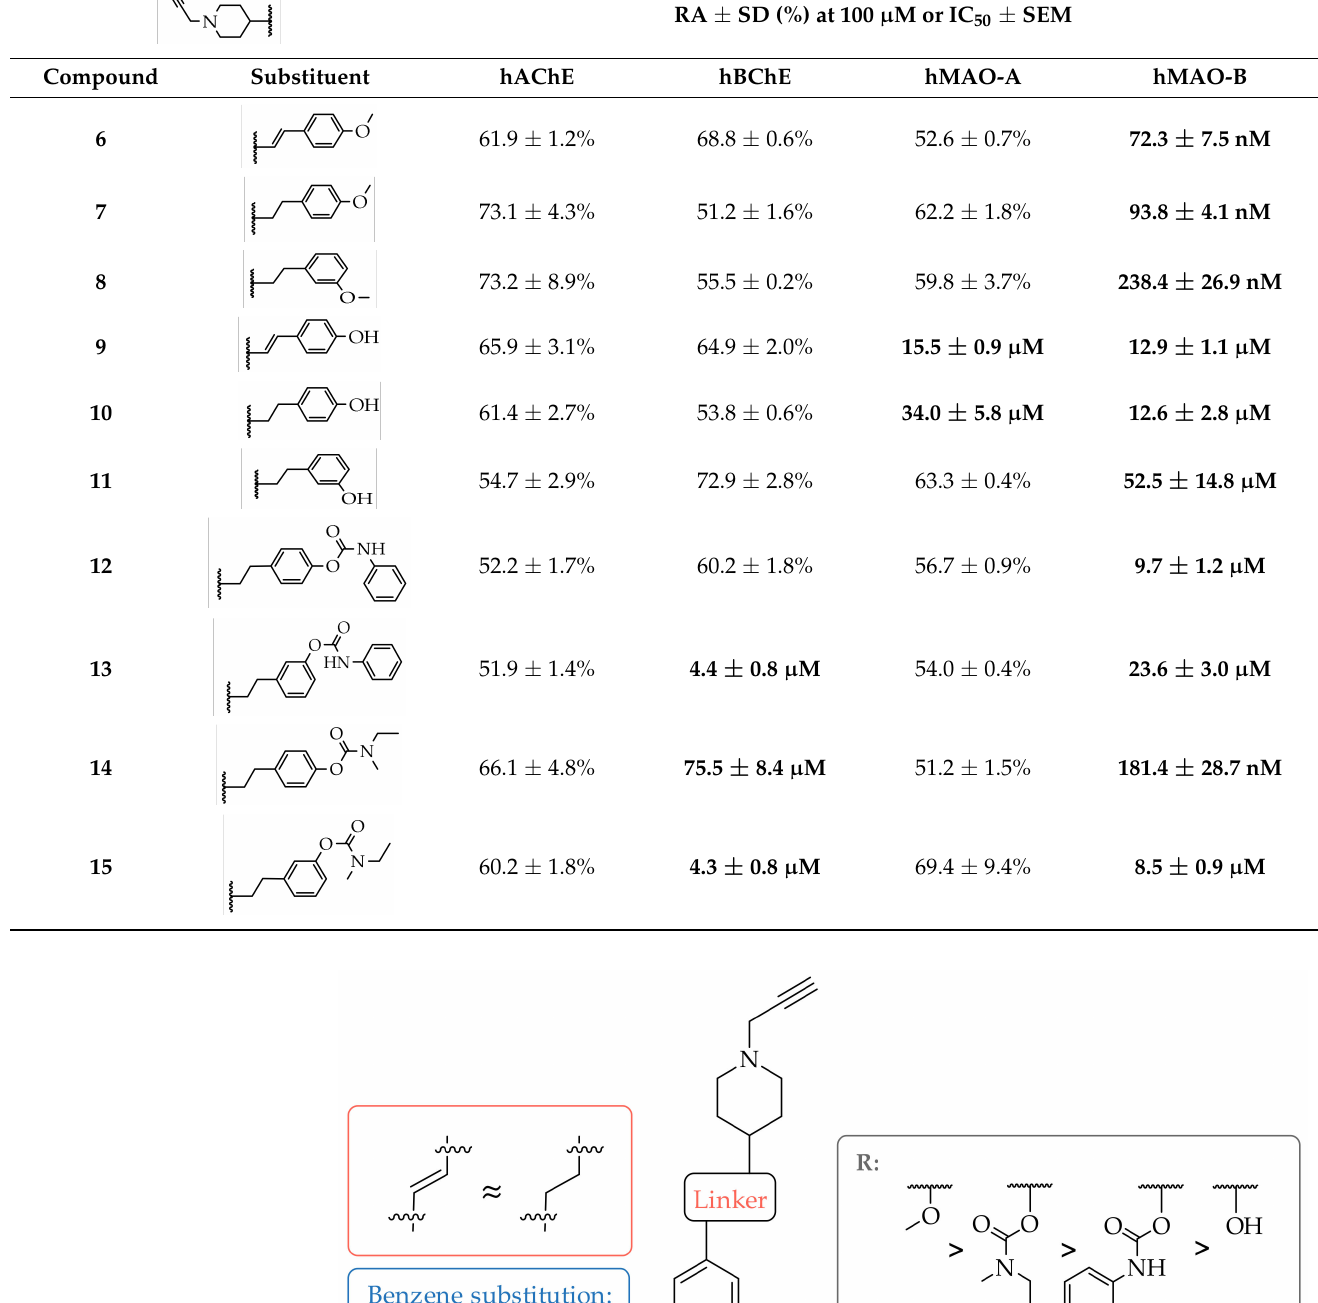
Table 1. Inhibitory potencies and structures of synthesized analogues. Compounds with RA above 50% were considered inactive. IC 50 values are presented as means ± S.E.M of 3 independent experiments.